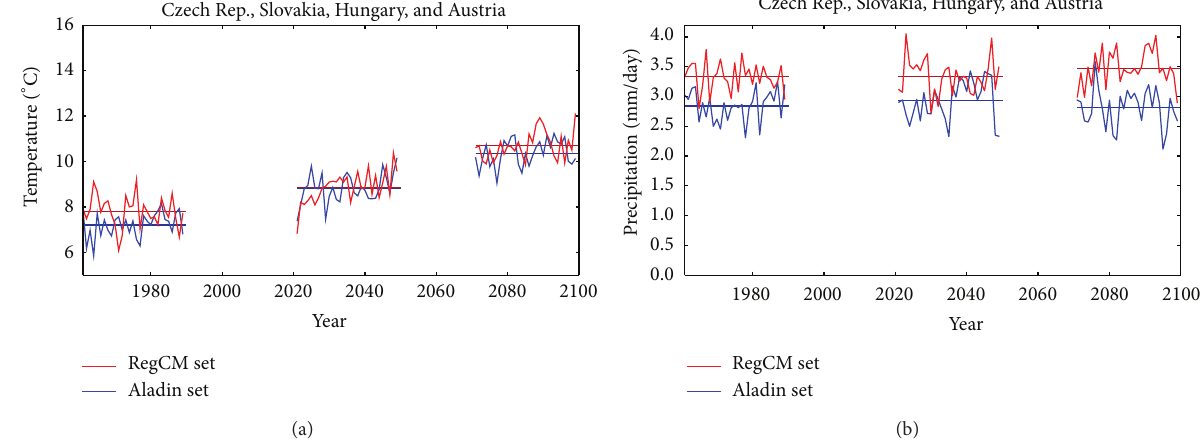
Figure 17: Average 2m temperature (a) and precipitation (b) over Central Europe; annual average (thin line) and 30-year average (thick line).